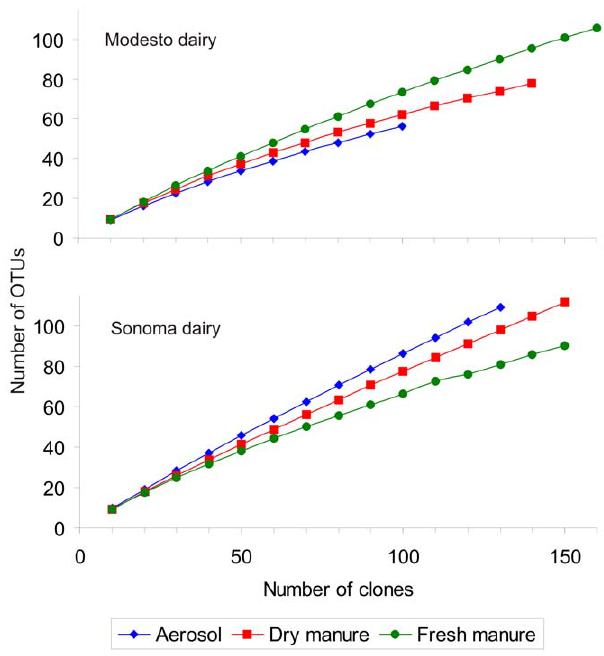
Figure 4. Rarefaction curves for 16S rRNA libraries of aerosol and manure samples from Modesto and Sonoma dairies. A total of 410 sequences representing 229 OTUs were used for rarefaction of clone libraries from Modesto (top panel), whereas 440 sequences representing 259 OTUs from Sonoma (bottom panel) were used.